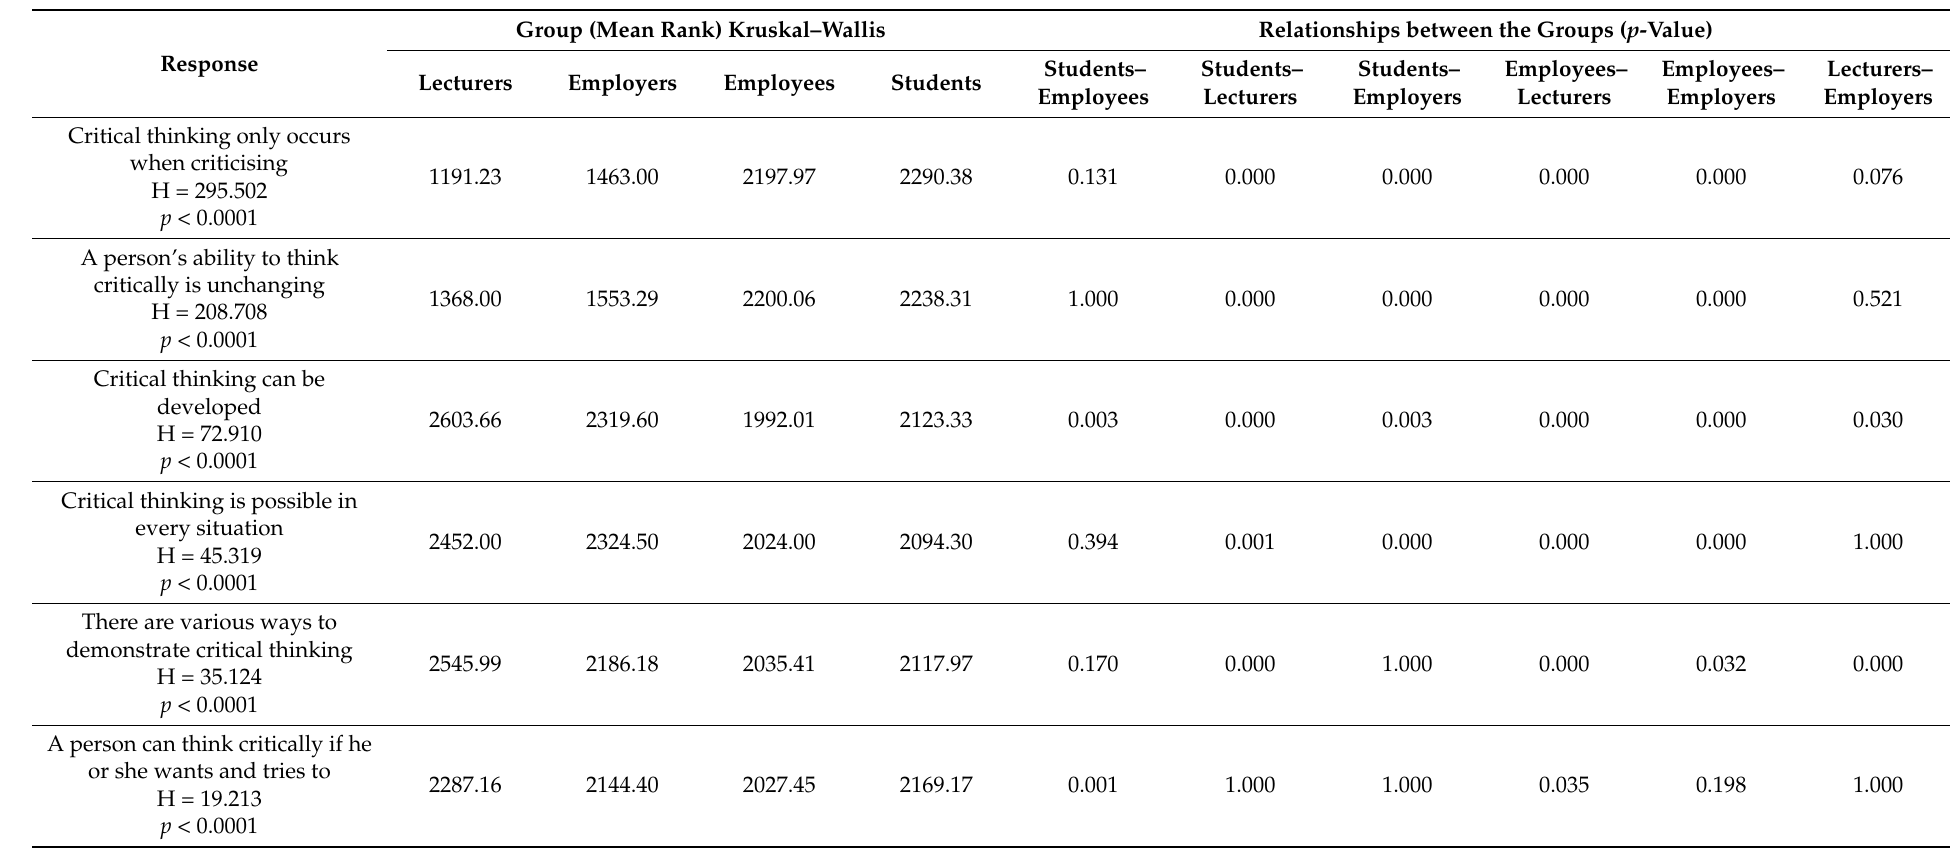
Table 4. Comparison of the views of the different study groups regarding the manifestation and development of critical